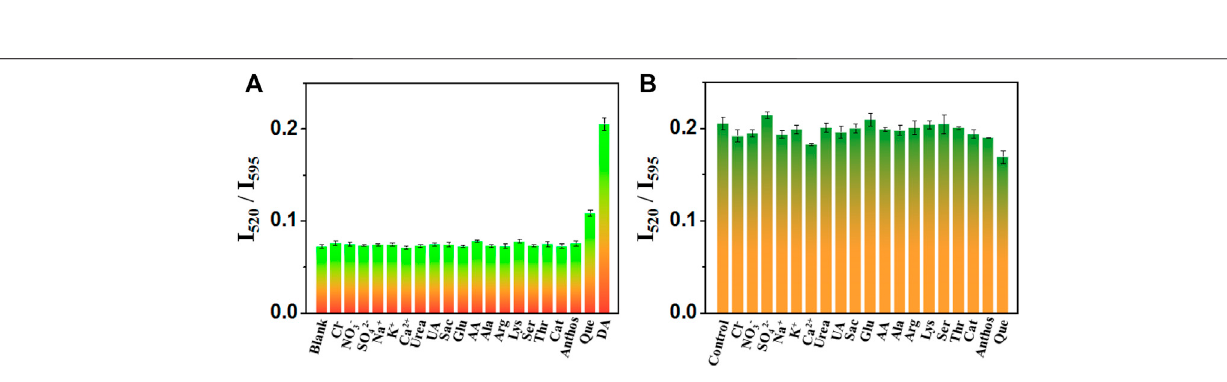
FIGURE4 |(A) Fluorescence emission spectra of hPEI-Au NCs solutionupon addingDA with various concentrations. (B) Plots of fl uorescence intensity ratio(I 520 / I 595 ) of hPEI-Au NCs solution vs. DA concentrations.